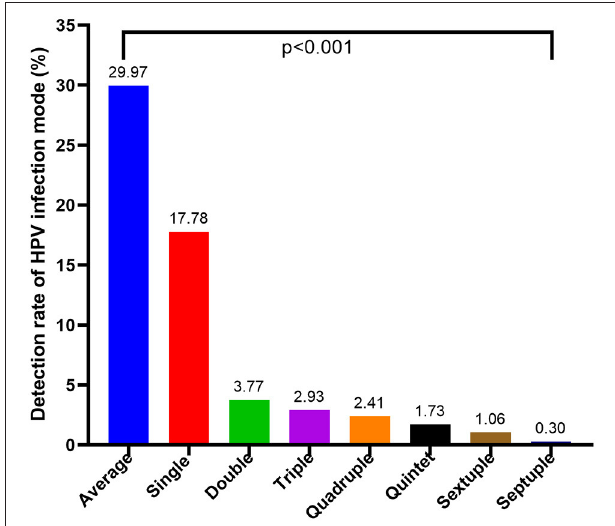
FIGURE 2 | Prevalence of single and multiple HPV infections ( p < 0.001).